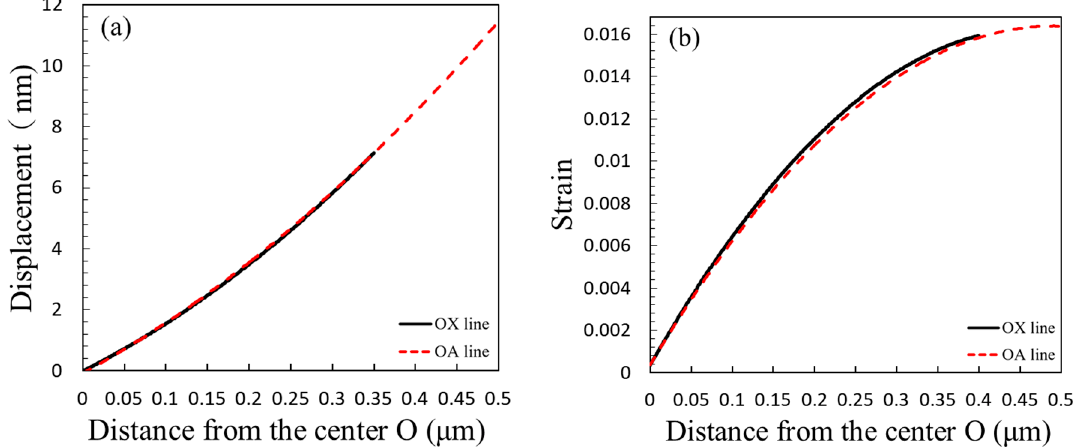
Figure 6. The illustration on an example of the displacement ( a ) and strain ( b ) along the rectangle coordinate of the edges OX and OA line from the center O of the ring core on Figure 5c.